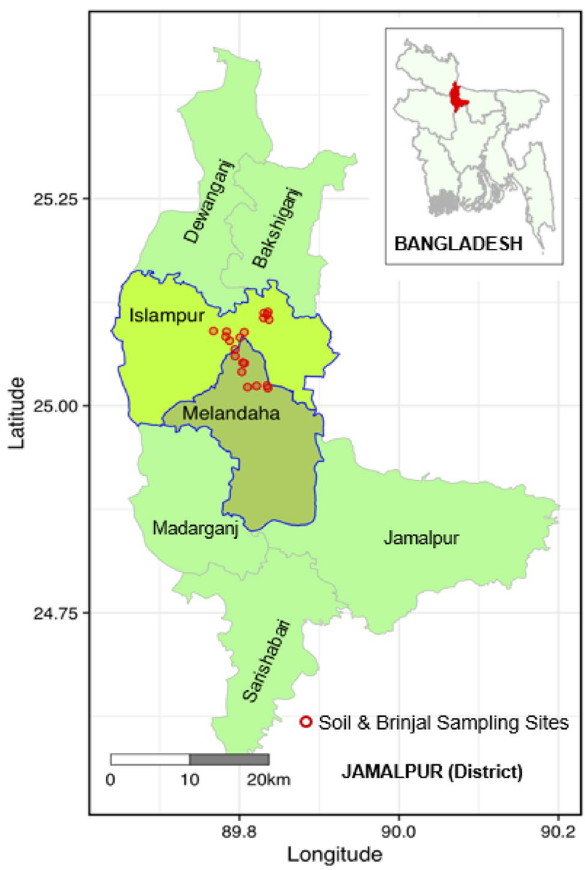
Figure 1. Map shows the soil and brinjal sampling locations of the farmers ′ fields of Melandaha and Islampur Upazila of Jamalpur district, Bangladesh.